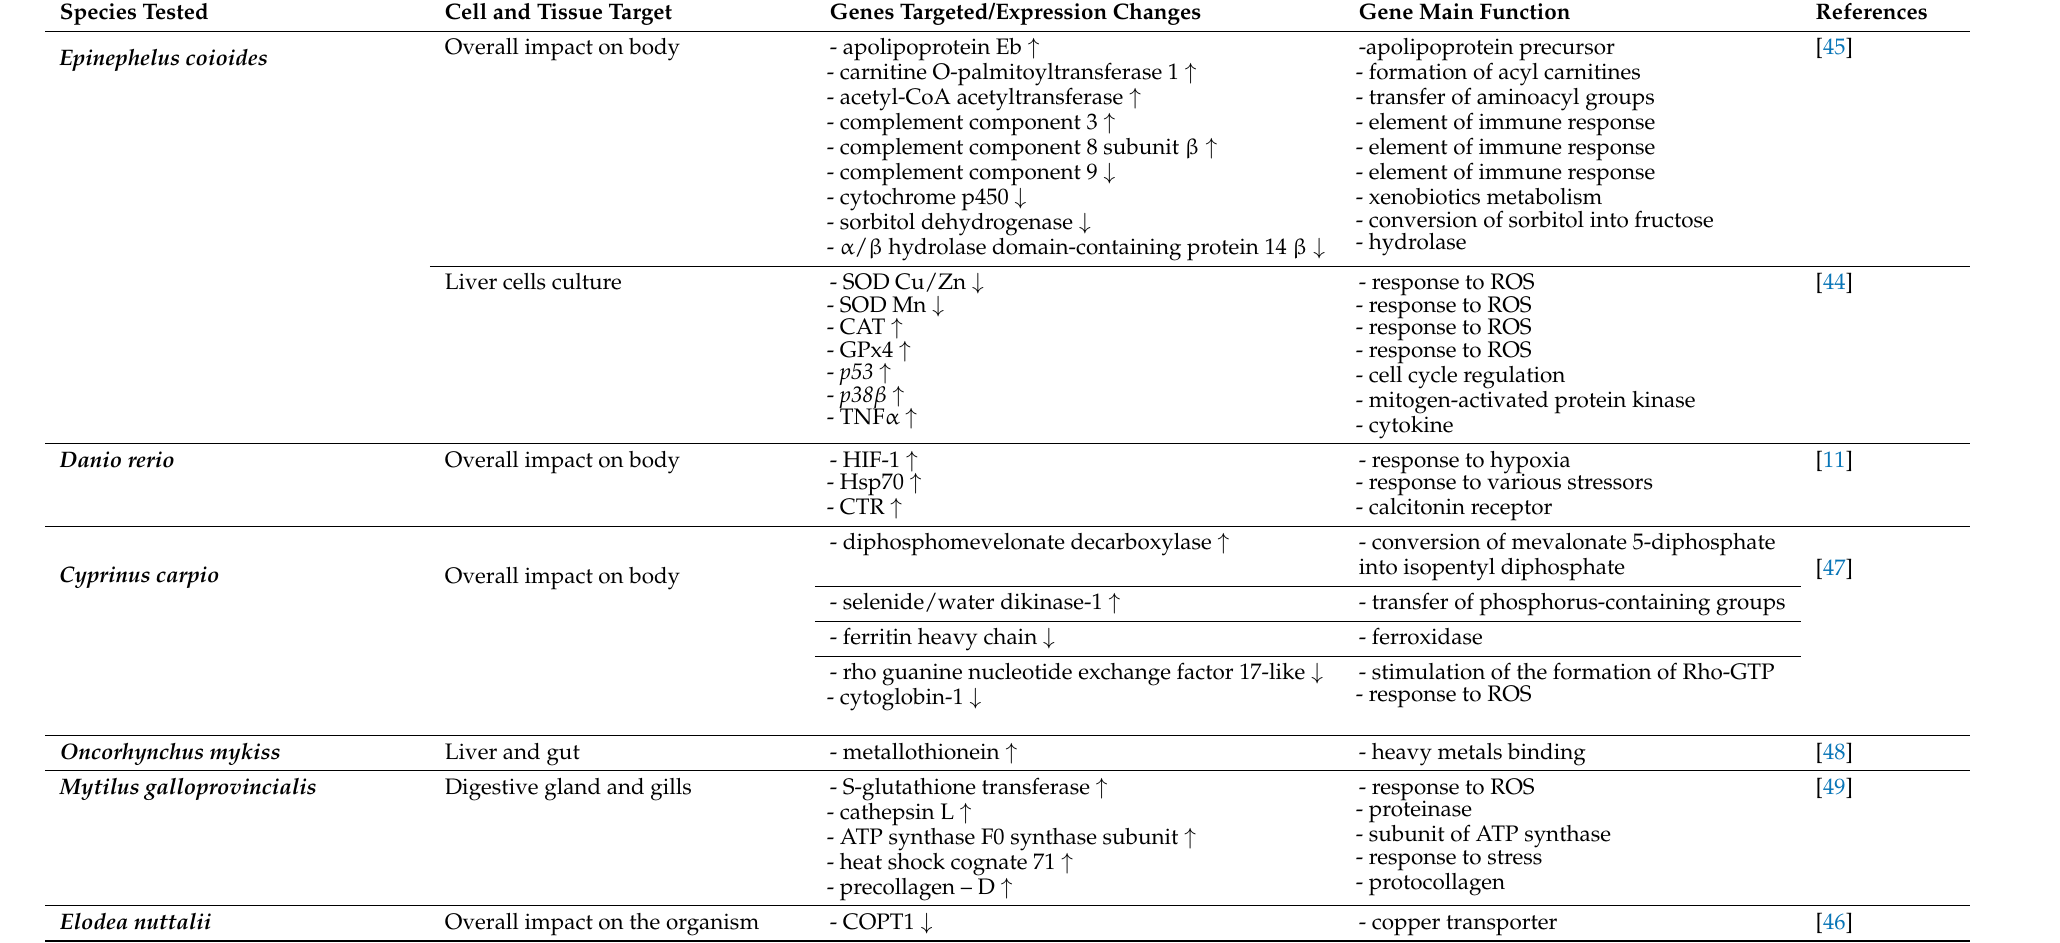
Table 2. Effects of copper nanoparticles on the expression of genes of water